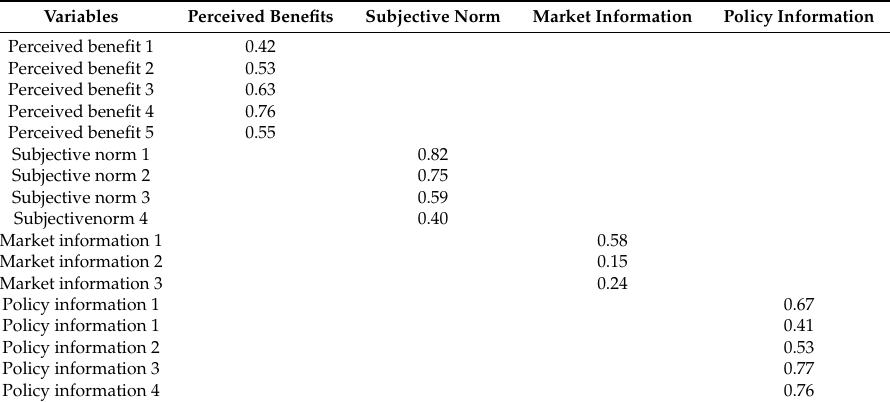
Table 3. Standardized factor-loadings for the observed indicators.